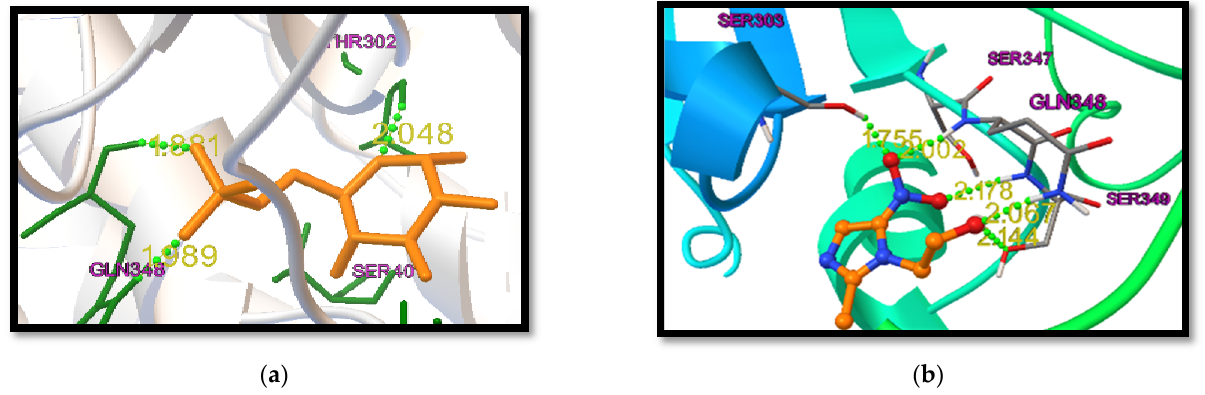
Figure 2. ( a ) Redocking of co-crystallized ligand GLP ( 28 ) in the binding pocket of glucosamine- fructose-6-phosphate synthase (2VF5). Ligand is shown as orange line model and the amino acid residues interacting with the ligands are shown as green line model. Hydrogen bond interactions (2.048, 1.989, 1.881 Å) with amino acid residues of glucosamine-fructose-6-phosphate synthase are shown in green dotted spheres. ( b ) Binding mode of standard drug metronidazole ( 3 ) in the binding pocket of glucosamine-fructose-6-phosphate synthase (2VF5). Ligand is shown as multicolor ball and stick model and the amino acid residues interacting with the ligands are shown as green line model. Hydrogen bond interactions (2.144, 2.067, 2.178, 2.002, 1.755 Å) with amino acid residues of glucosamine-fructose-6-phosphate synthase are shown in green dotted spheres.